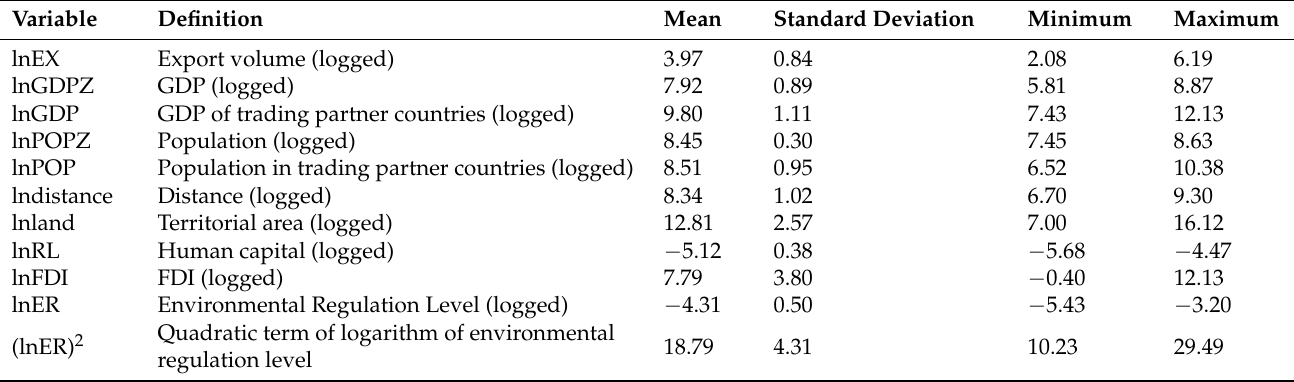
Table 2. Descriptive